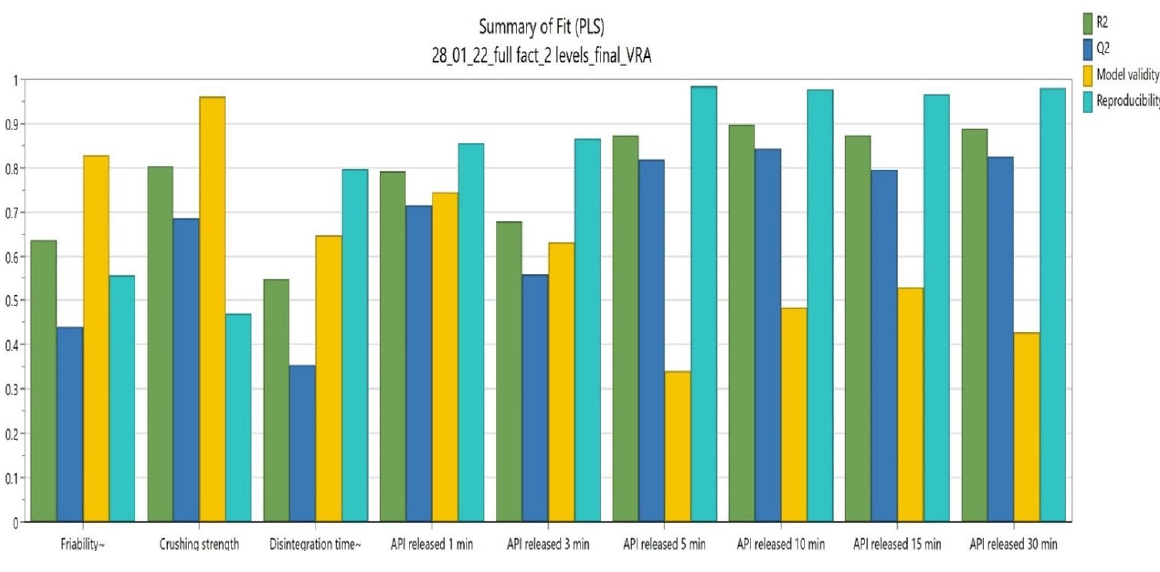
Figure 3. Summary of fit. Table 7. Quality of fit—Statistical parameters. Table 7. Quality of fit—Statistical